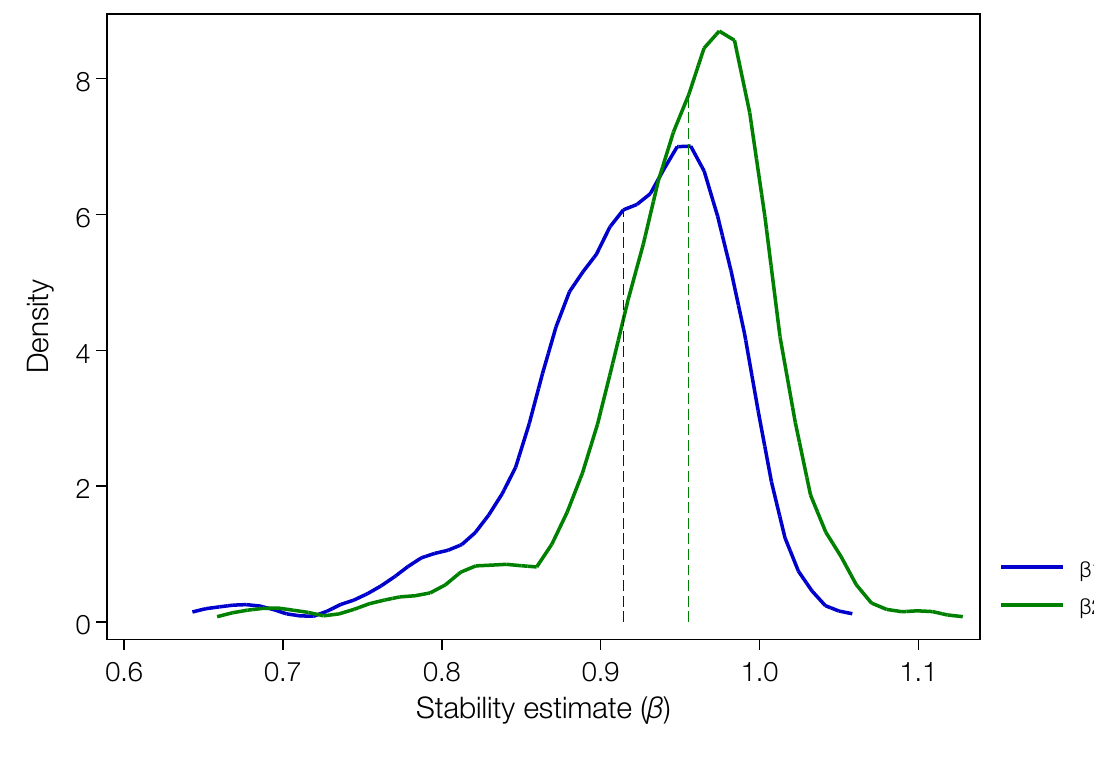
Figure 9: Kernel density curves for stability estimates between the first and second waves ( β third waves ( β 2 ) for nonfixed